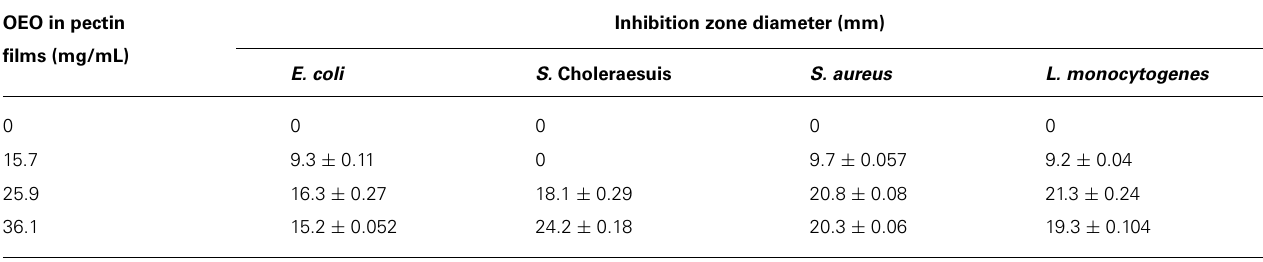
Table 2 | Inhibition zones of pectin-OEO films against pathogenic bacteria.